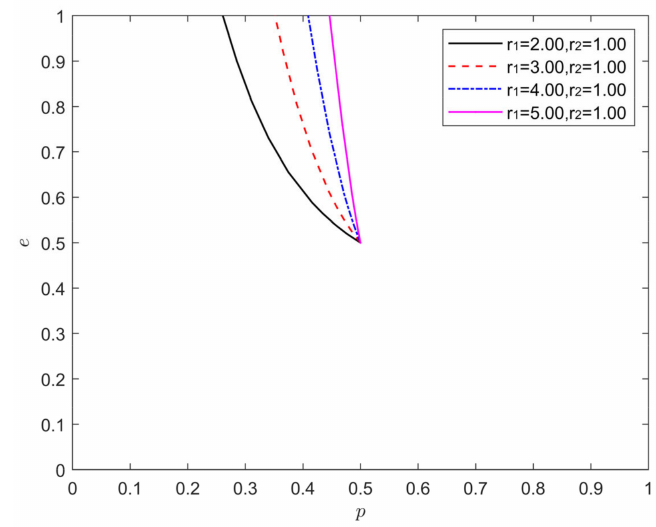
Figure 7. The development of the game’s strategy in a (pessimistic, rational) condition.